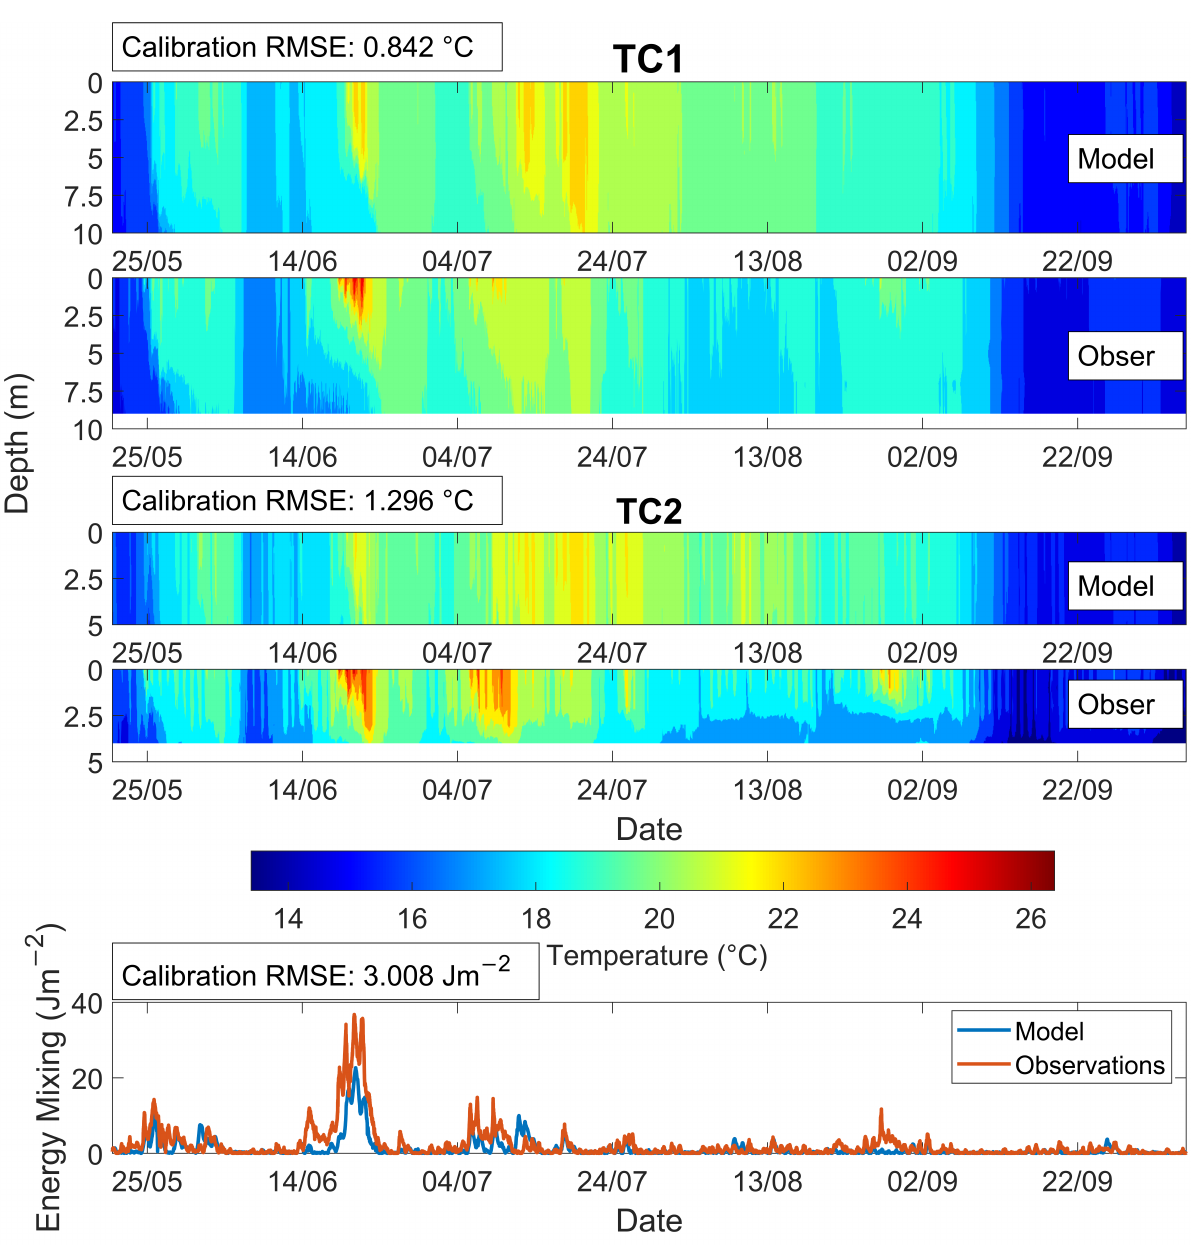
Figure 7. Assessment of model performance when forcing data was averaged daily then placed through the down-scaling procedure. Contour plots show comparisons between modelled with down-scaled forcing data and observations for temperature ( top panels). Also shown is a plot of S over time between the observed and modelled runs ( bottom panel). RMSE between these observations and down-scaled model data is also